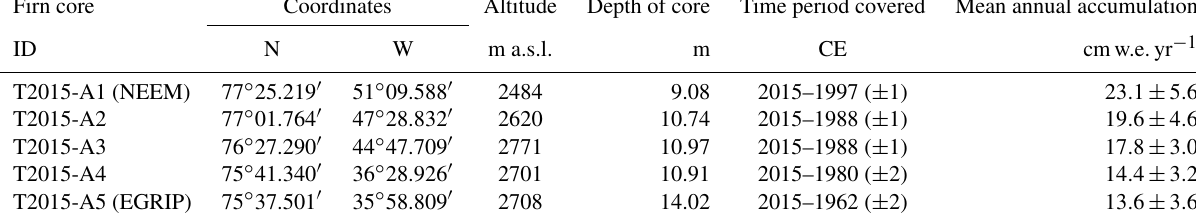
Table 1. Name, latitude, longitude, altitude, core depths, bottom age and mean accumulation (Kjær et al., 2021b) of the shallow firn cores presented in this study. The firn cores are labeled T2015-A1 to T2015-A6. All cores were drilled in 2015 and measured by means of CFA in Copenhagen in 2017.